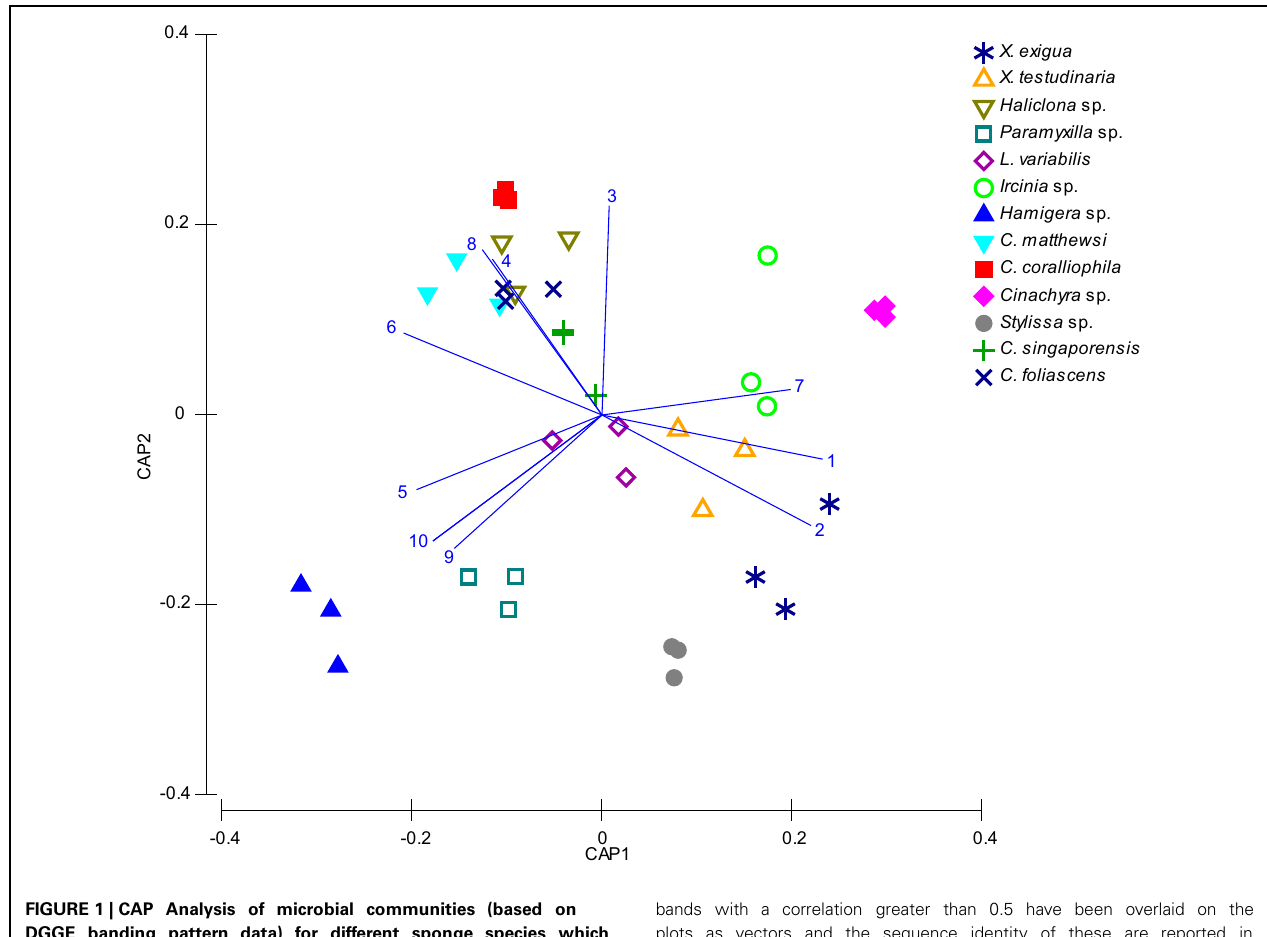
FIGURE 1 | CAP Analysis of microbial communities (based on DGGE banding pattern data) for different sponge species which were all sampled in triplicate (depicted by each shape). DGGE